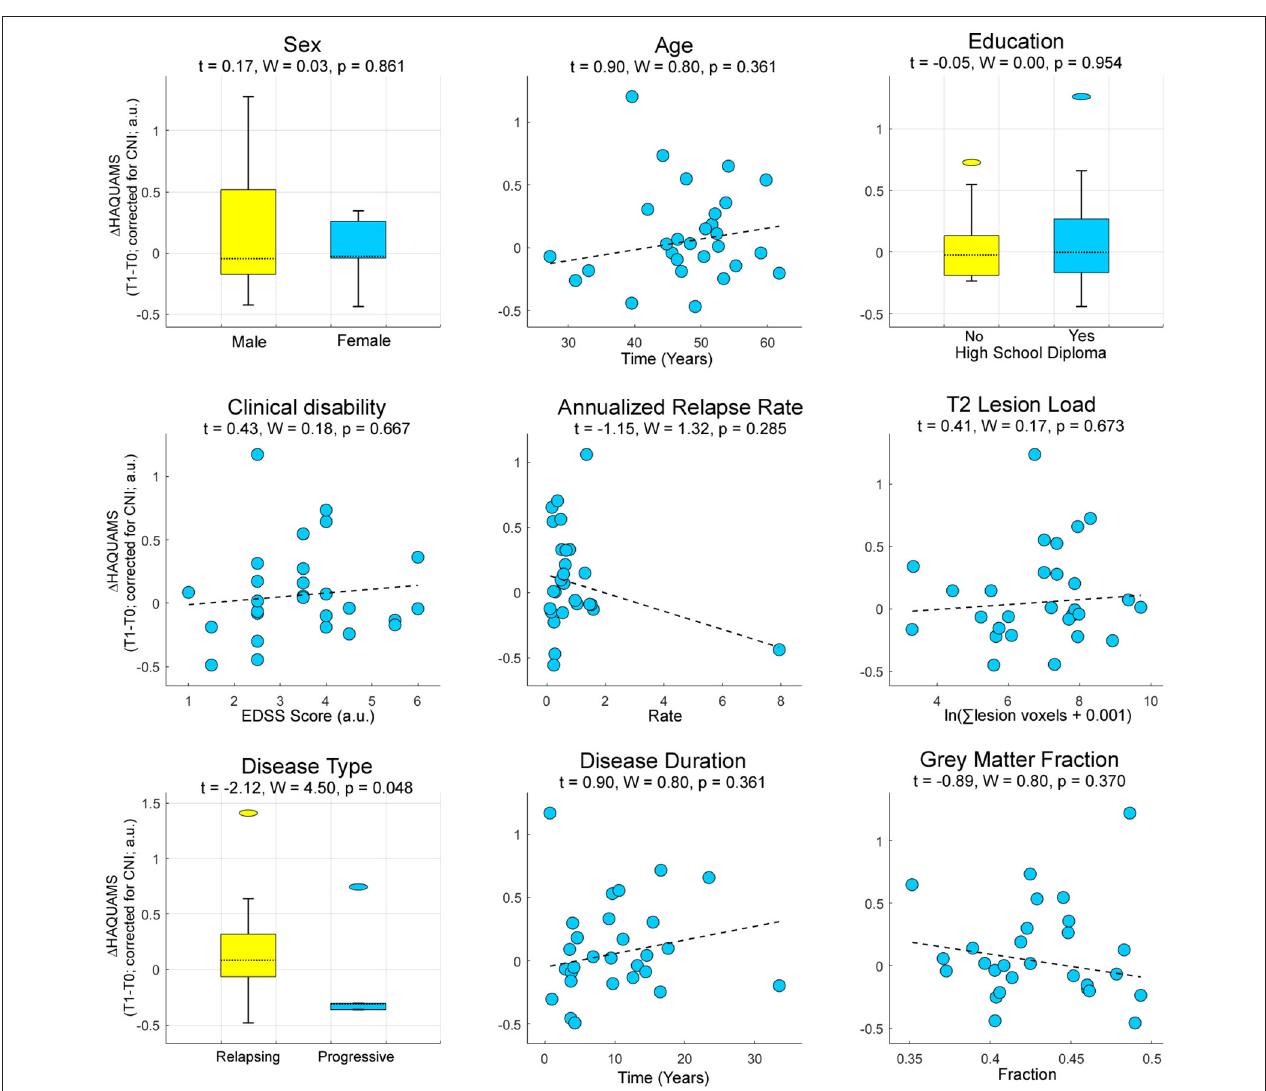
FIGURE 4 | Prognostic information of established clinical, demographic, and radiographic parameters for future variations in overall HRQoL. Higher 1 HAQUAMS scores correspond to stronger longitudinal declines in HRQoL. W,